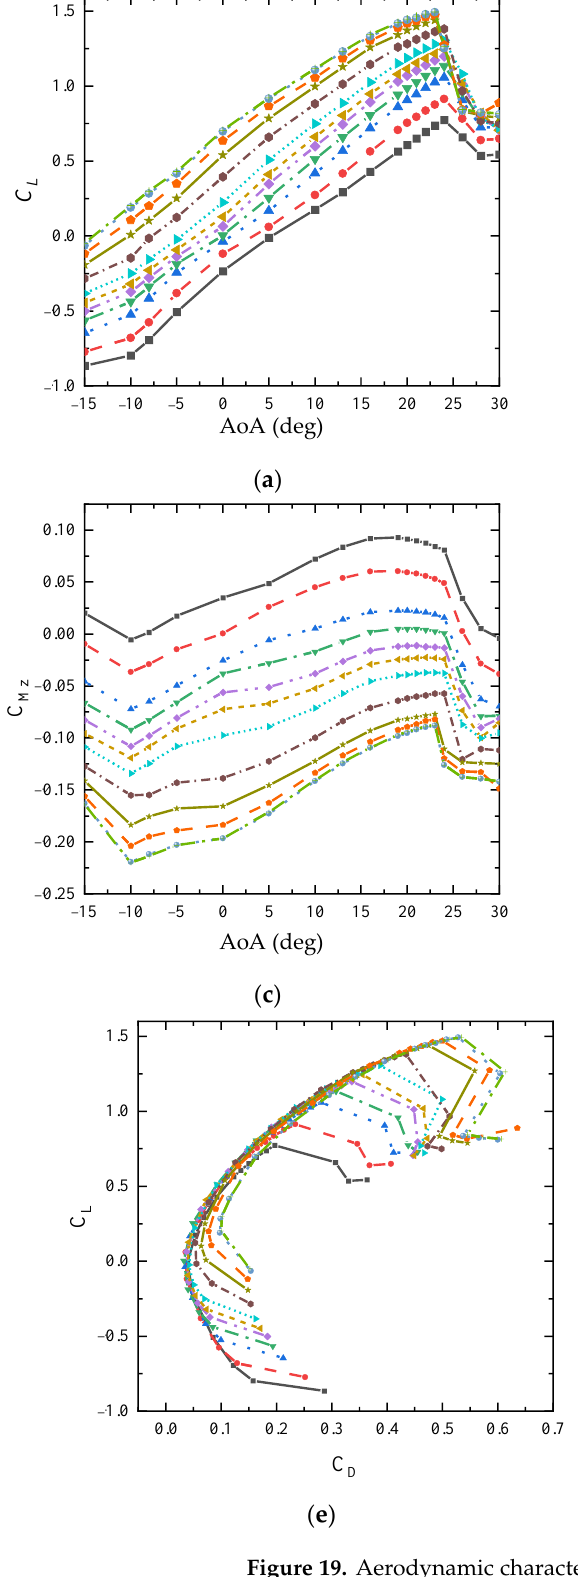
Figure 19. Aerodynamic characteristics for mTE4 (Airspeed 25 m/s). ( a ) Lift coefficient. ( b ) Drag coefficient. ( c ) Pitch moment coefficient. ( d ) Efficiency. ( e ) Polar.